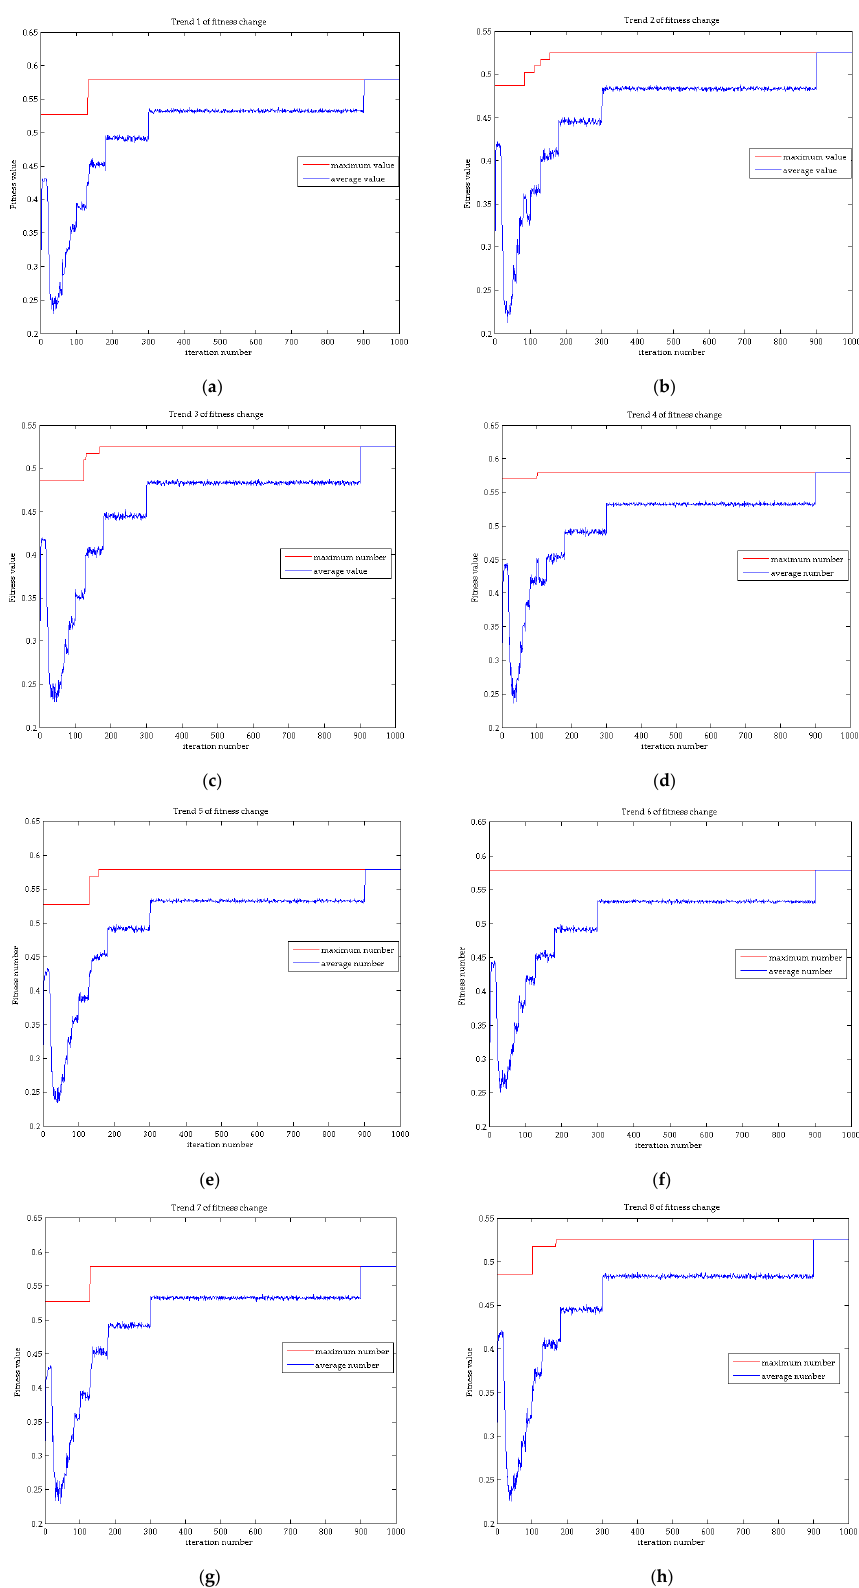
Figure 9. ( a ) Trend 1 of fitness change; ( b ) Trend 2 of fitness change; ( c ) Trend 3 of fitness change; ( d ) Trend 4 of fitness change; ( e ) Trend 5 of fitness change; ( f ) Trend 6 of fitness change; ( g ) Trend 7 of fitness change; ( h ) Trend 8 of fitness change.